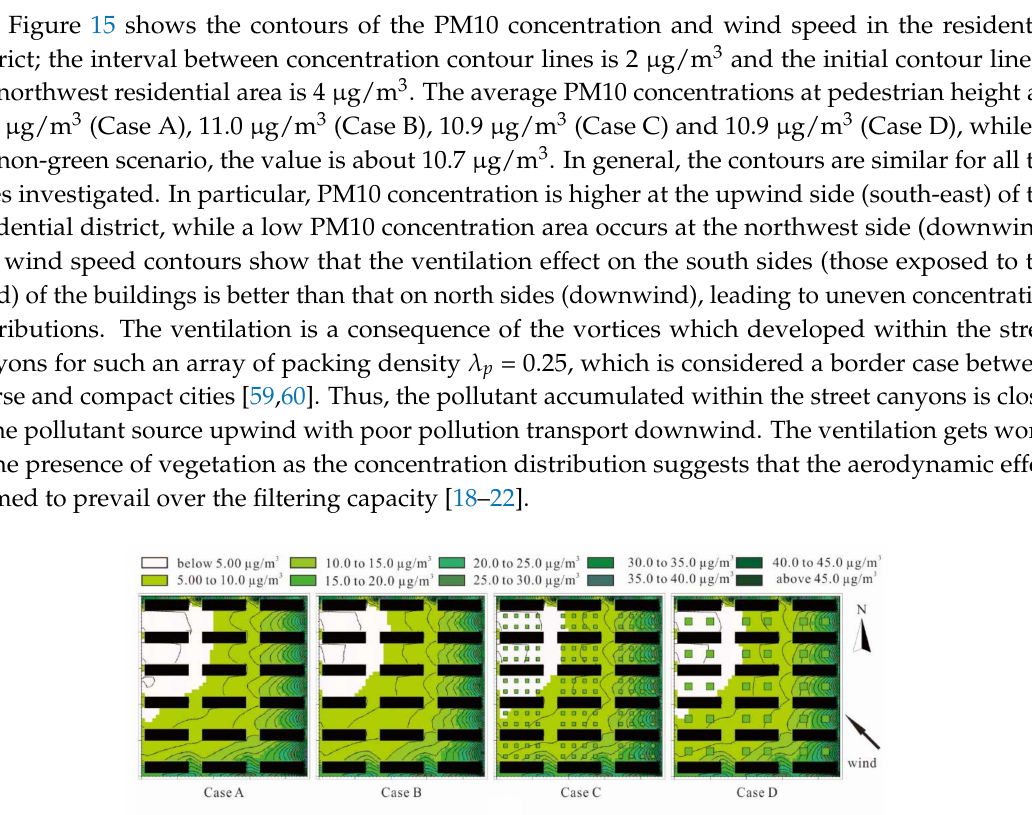
Figure 14. Temporal profile of PM10 concentration at point Q.